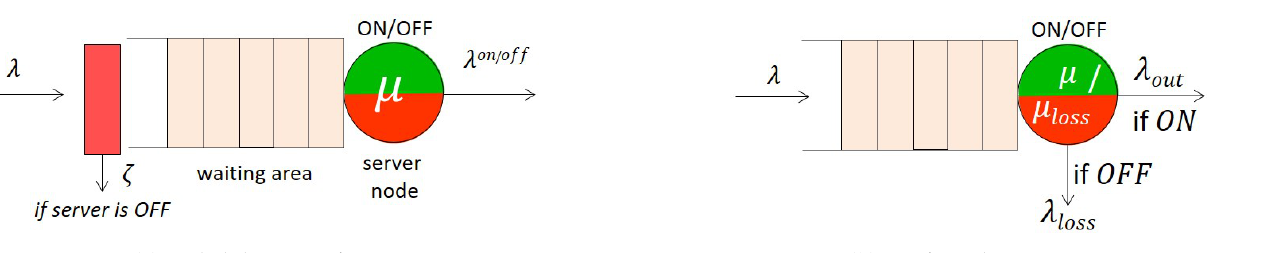
Figure 2. Probabilistic and loss ON/OFF